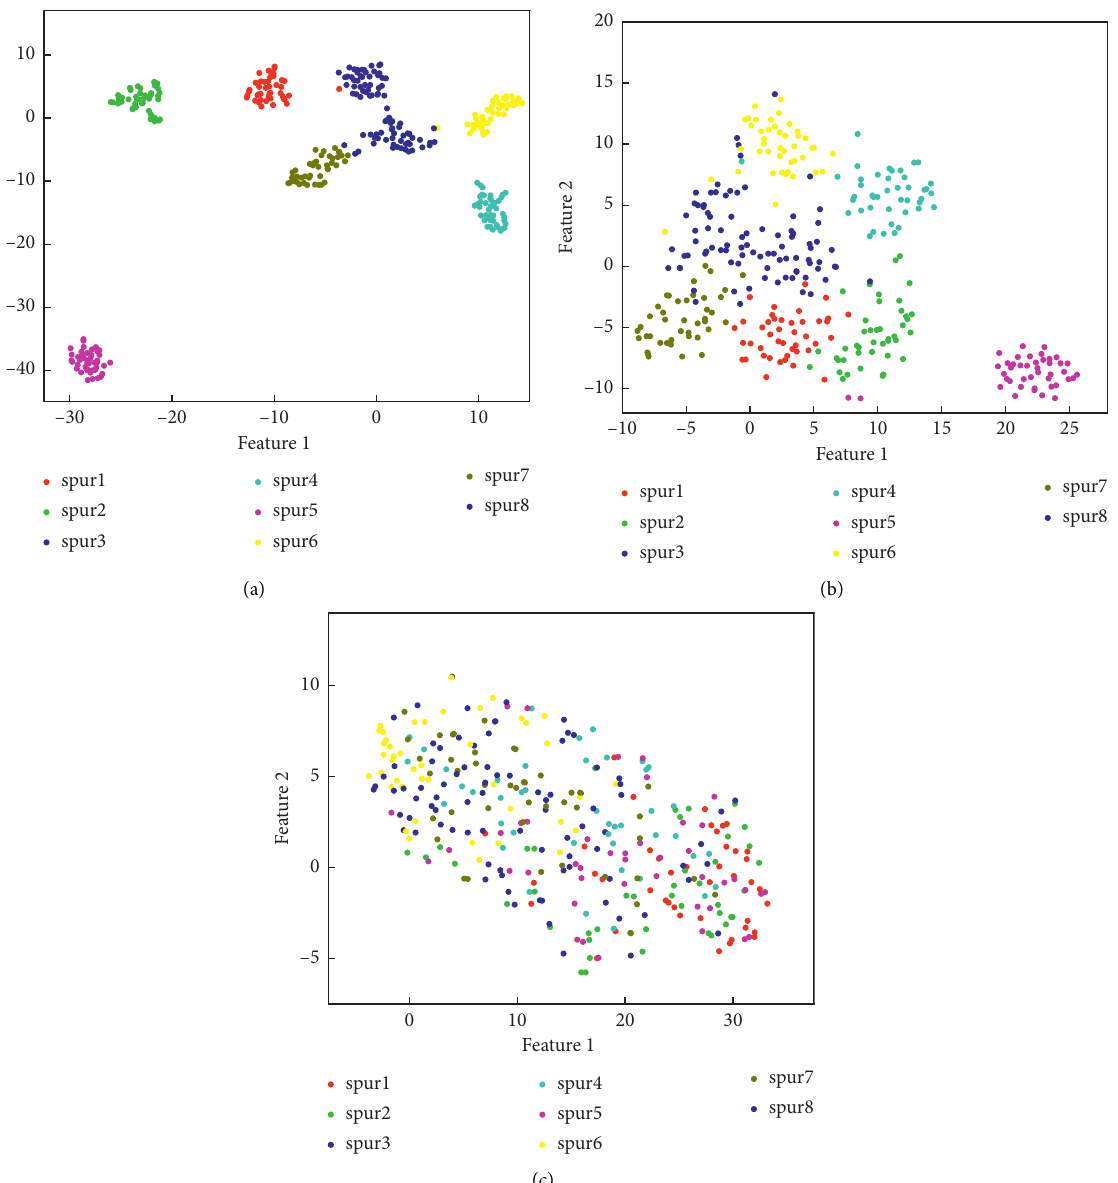
Figure 18: The performance comparison of the two-dimensional feature vectors reduced by the t-SNE method of the gearbox’s 8 working conditions extracted by ImvMAAPE (a), mvMAAPE (b), and MAAPE (c)